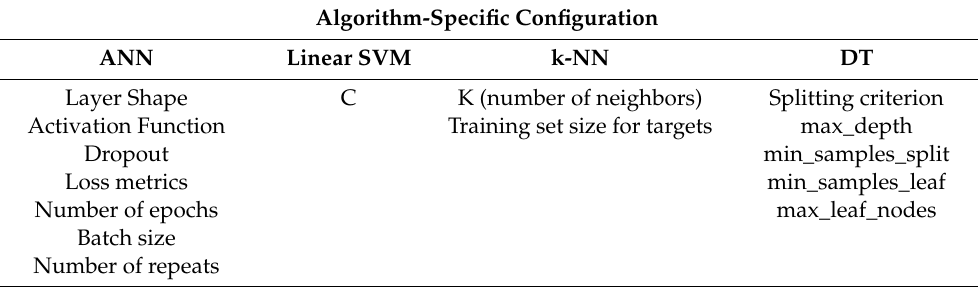
Table 2. Algorithm-specific configuration